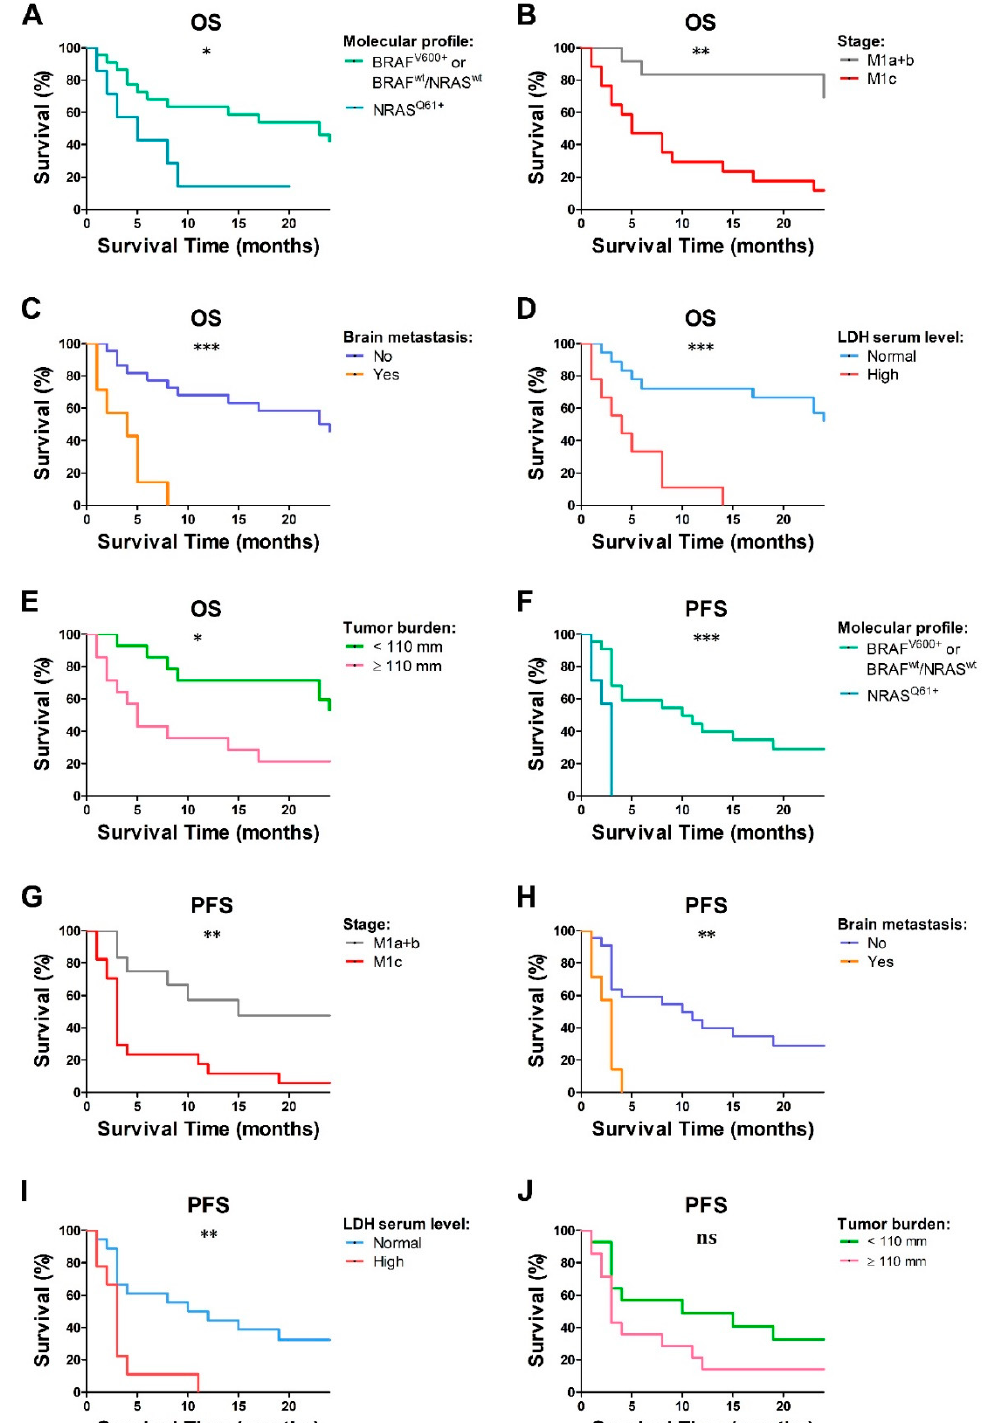
Figure 5. Survival analysis of MM patients. Overall survival (OS) ( A – E ) and progression-free survival (PFS) ( F – J ) according to molecular profile ( N = 29; ( A , F )), stage of melanoma ( N = 29; ( B , G )), presence of brain metastases ( N = 29; ( C , H )), LDH serum level ( N = 27; ( D , I )), and tumor burden ( N = 28; ( E , J )) are reported. Survival analysis was performed using the Kaplan–Meier method and the statistical significance was calculated by the log-rank test. * p < 0.05; ** p < 0.01; *** p < 0.001; ns = not statistically significant p -value.